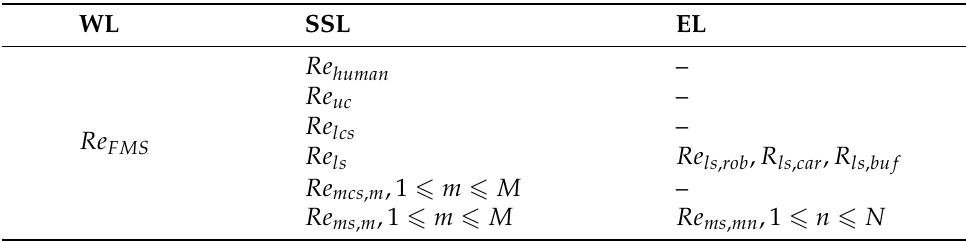
Table 2. Three-layer reliability evaluation index